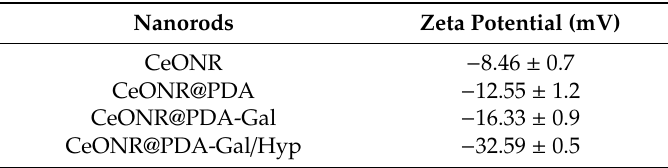
Table 1. The Zeta potential of